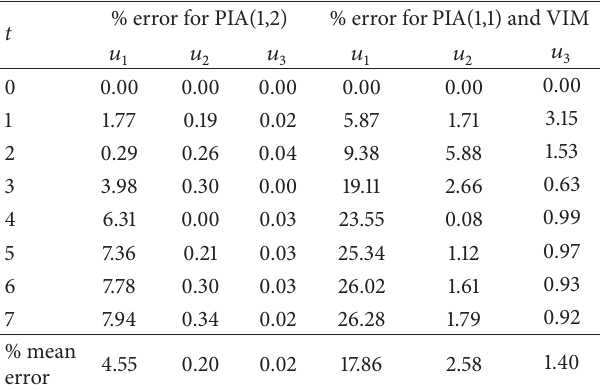
Table 1: Comparison of percentage errors of PIA(1, 2) with PIA(1, 1) and VIM for 𝜀 = 1